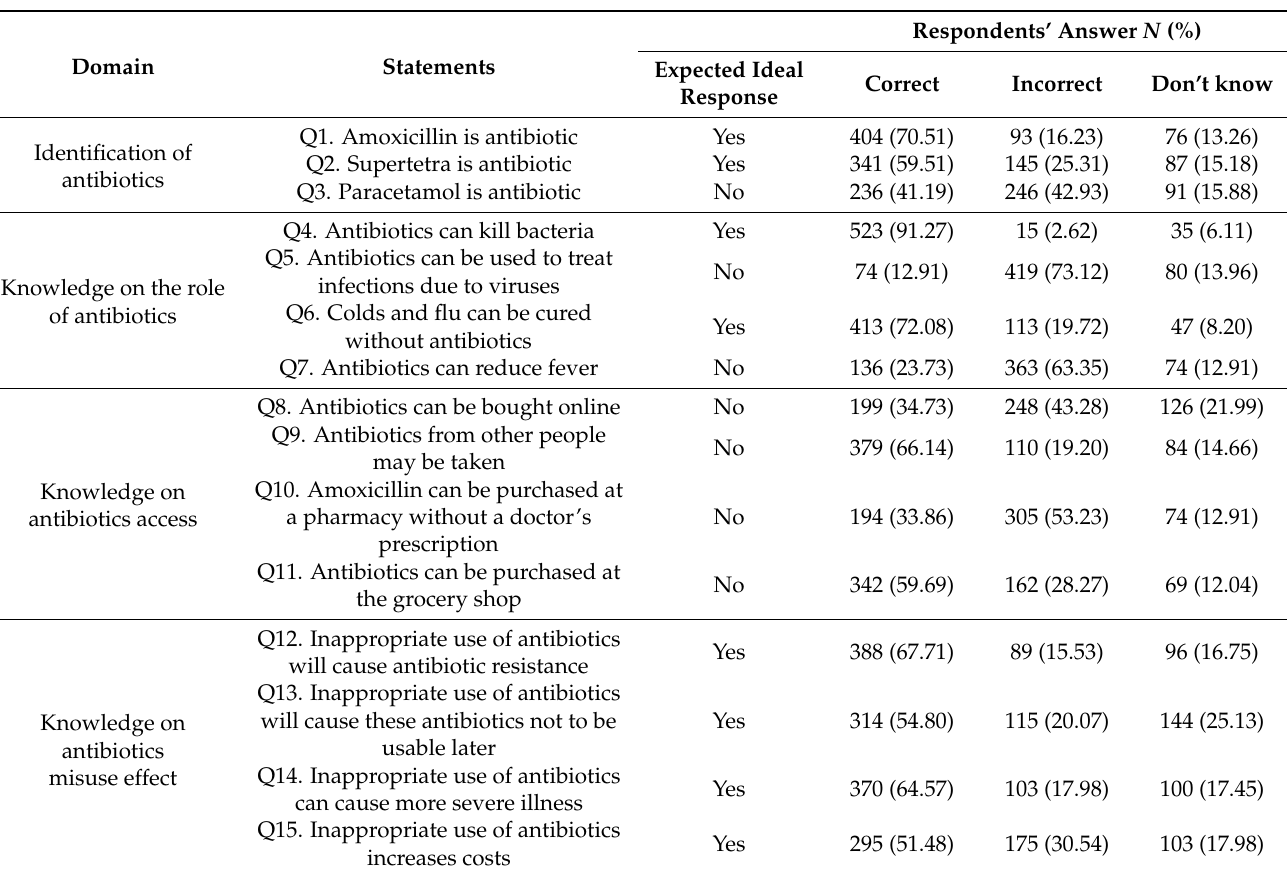
Table 3. Responses to the questionnaire on antibiotic knowledge ( N =